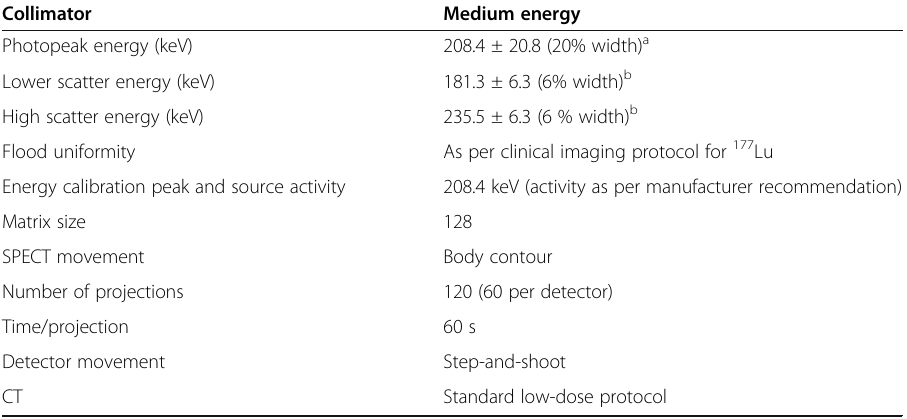
Table 2 SPECT/CT acquisition